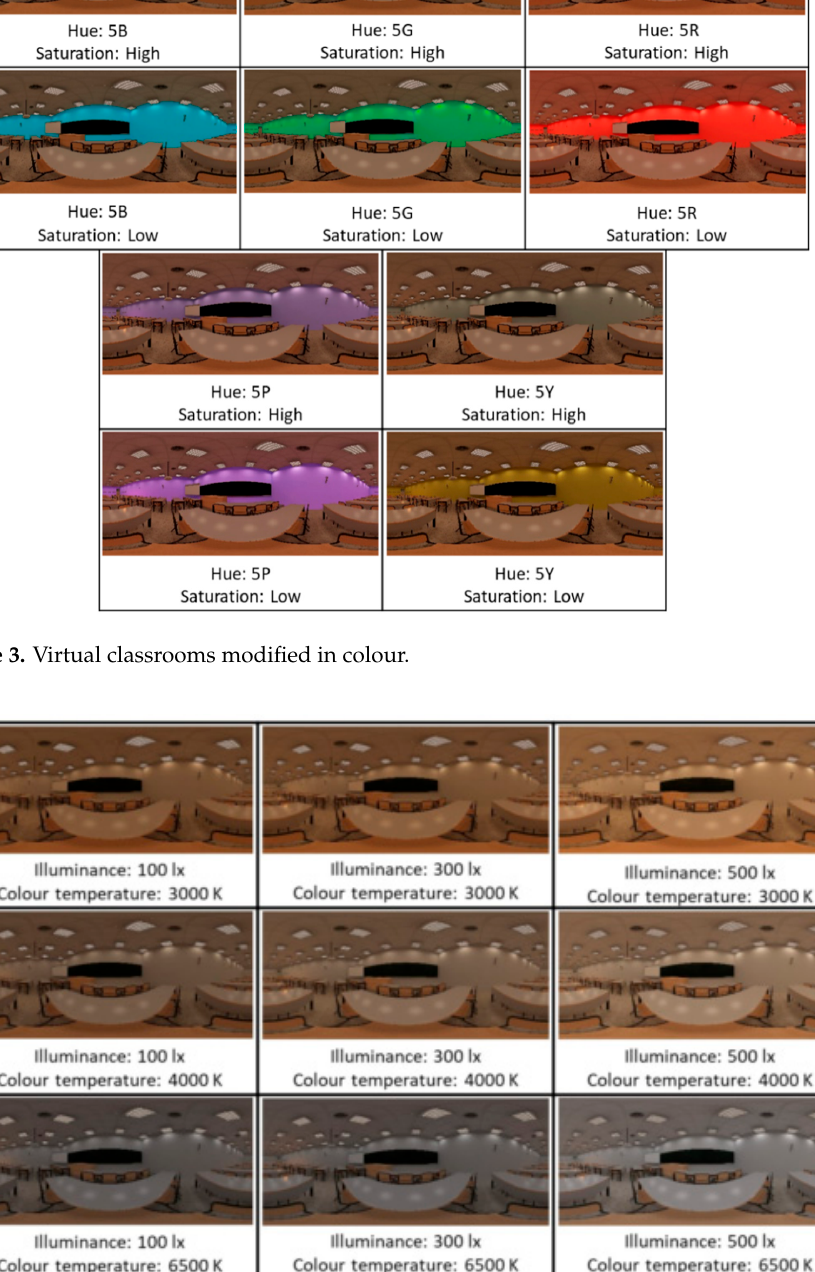
Figure 4. Virtual classrooms modified in lighting.